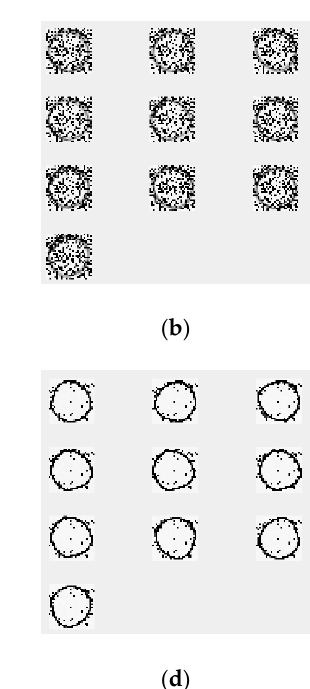
Figure 10. Network structure of the Autoencoder.